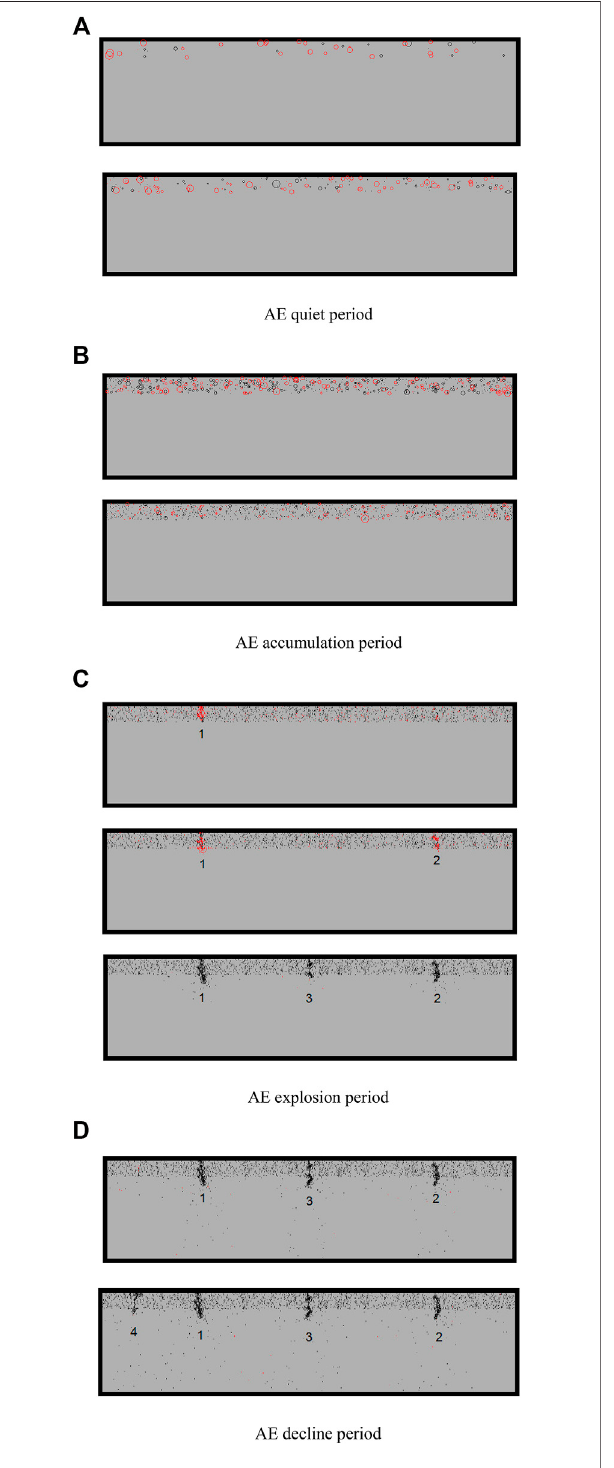
FIGURE7| SampleAEevolutionwithcoolingdown4 ° Cperstep. (A) AE quiet period, (B) AEaccumulationperiod, (C) AEexplosionperiod,and (D) AE decline